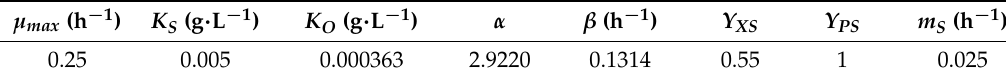
Table 1. Values for constants in the bioprocess kinetic